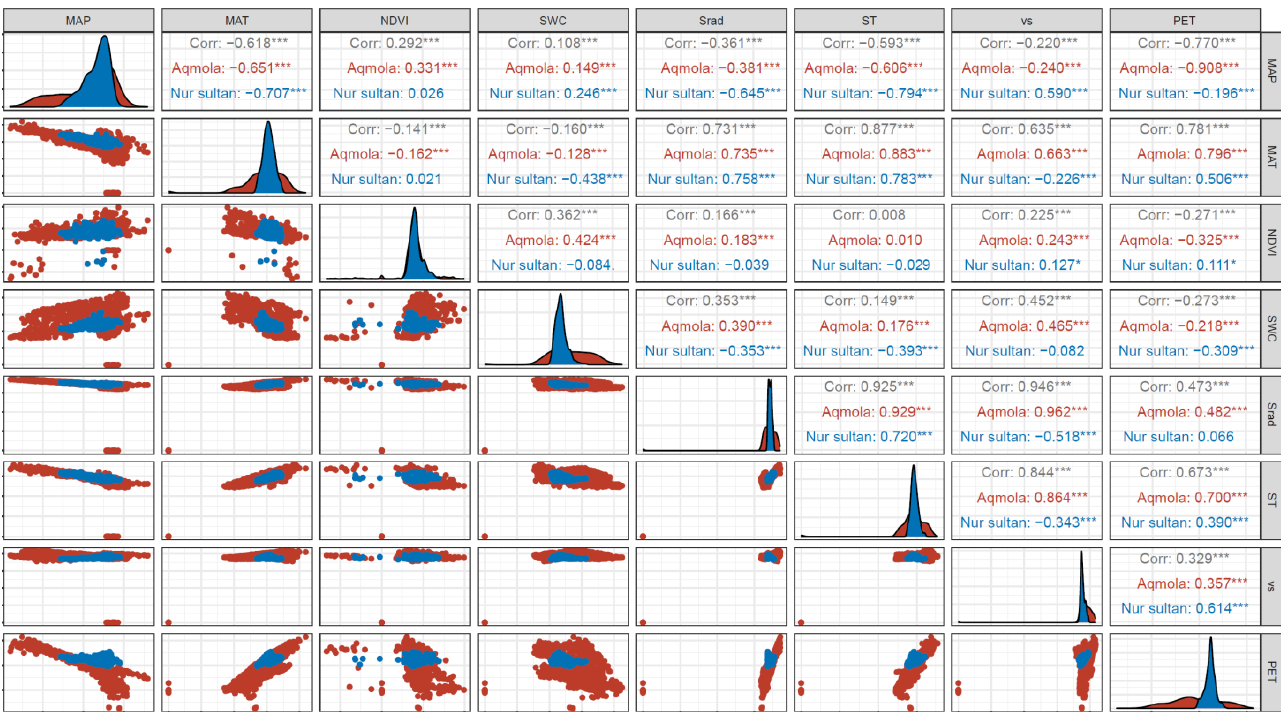
Figure 6. Simple correlation between PET and environmental factors in Akmola State and the metropolitan area.*: P < 0.1; ** P < 0..05; *** P < 0.01.